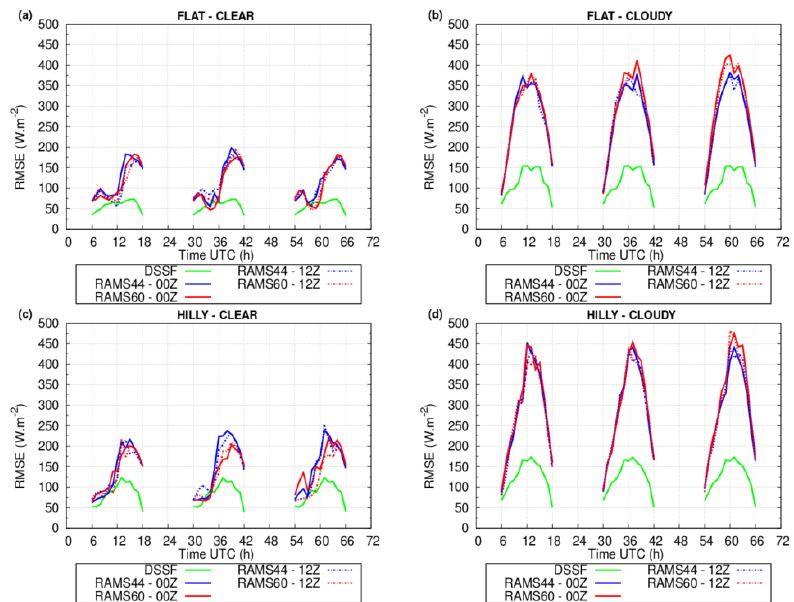
Figure 8. Same as Figure 6, but for the RMSE (W·m − 2 ) statistical score: flat-clear ( a ); flat-cloudy ( b ); hilly-clear ( c ) and hilly-cloudy ( d ).